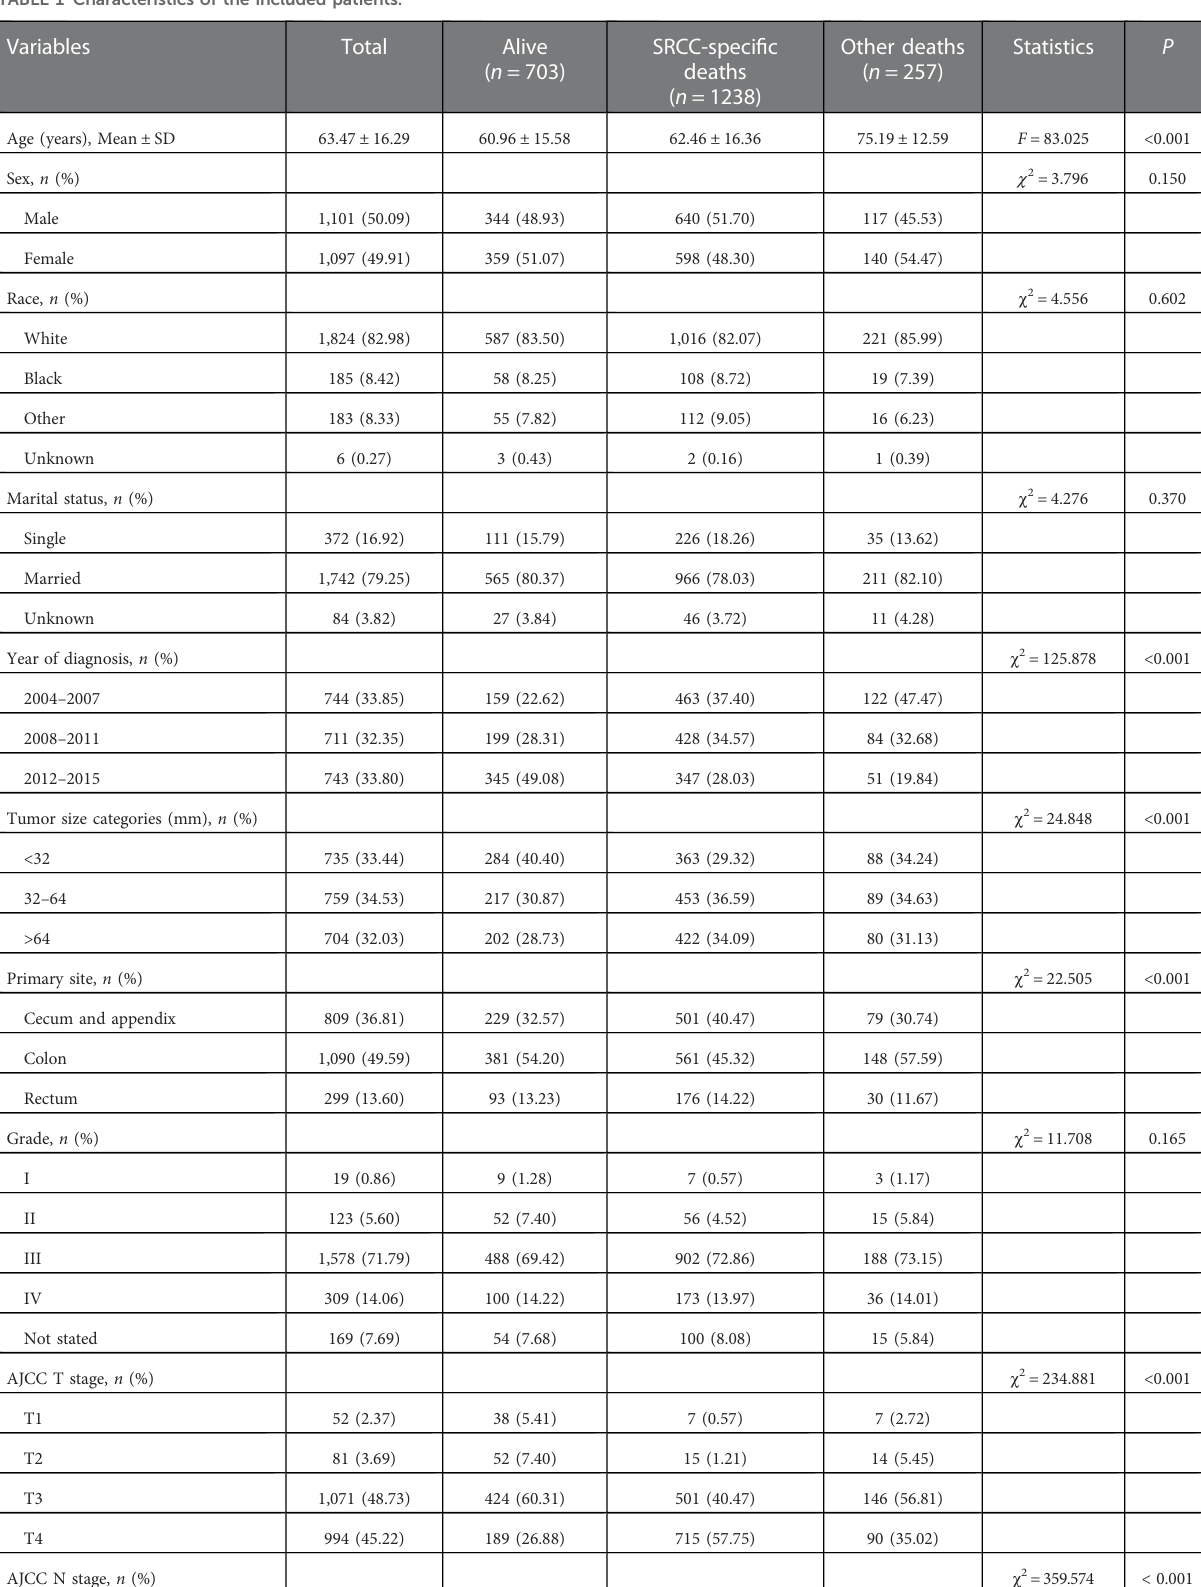
TABLE 1 Characteristics of the included